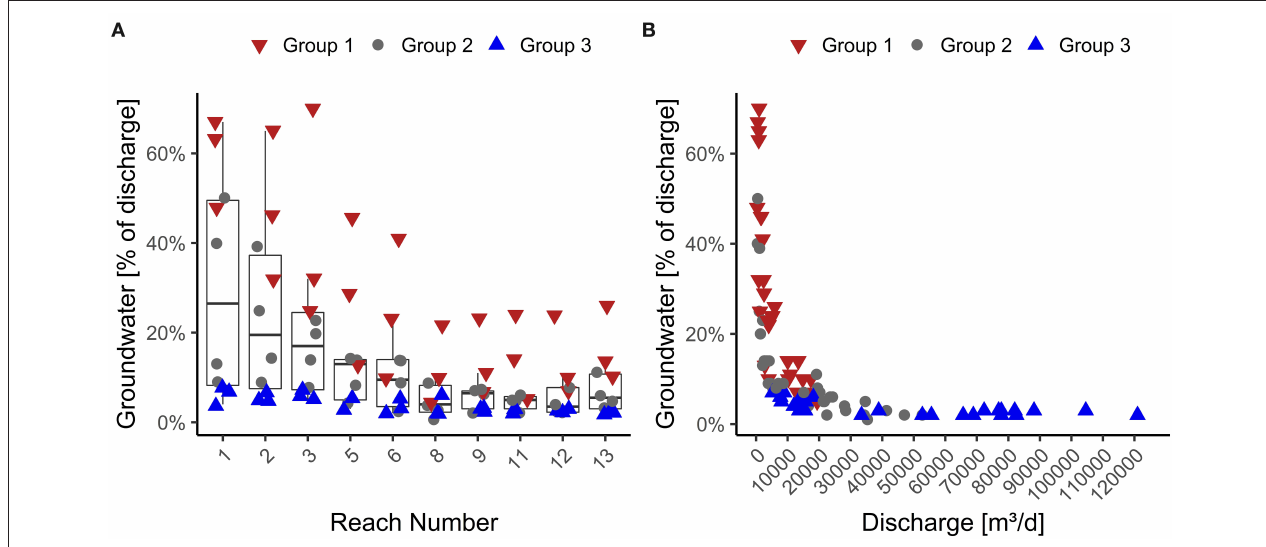
FIGURE 6 | Left (A) Variation of groundwater inflow in % of the total discharge in the measurement period for each reach. Right (B) Groundwater inflow in % of the total discharge over discharge for the